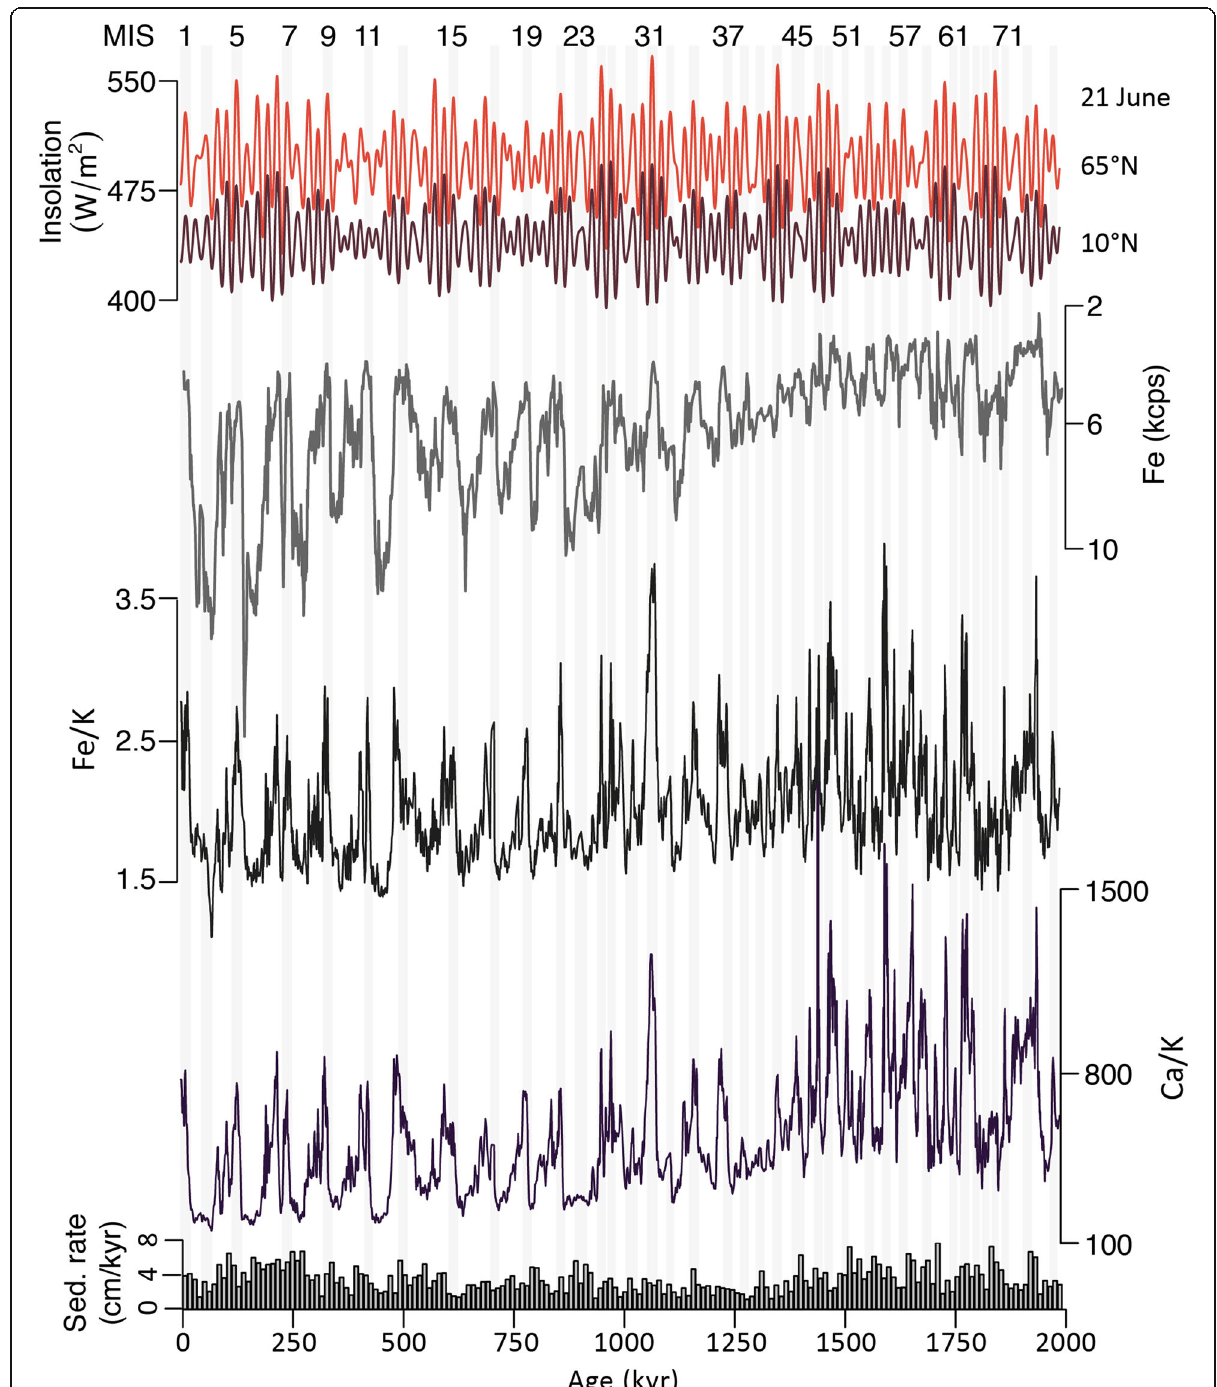
Fig. 8 The Fe intensity, Fe/K and Ca/K records tuned to the 65° N 21st June insolation curve by Laskar et al. (2004). The 10° N 21st of June and MIS are shown; tie points between the records are indicated in Additional file 1: Table S1, a three-point moving average smoothing was applied to highlight the cycles. Note that the y axis on the Fe intensity record is reversed. Sedimentation rates vary between 1.15 and 7.7